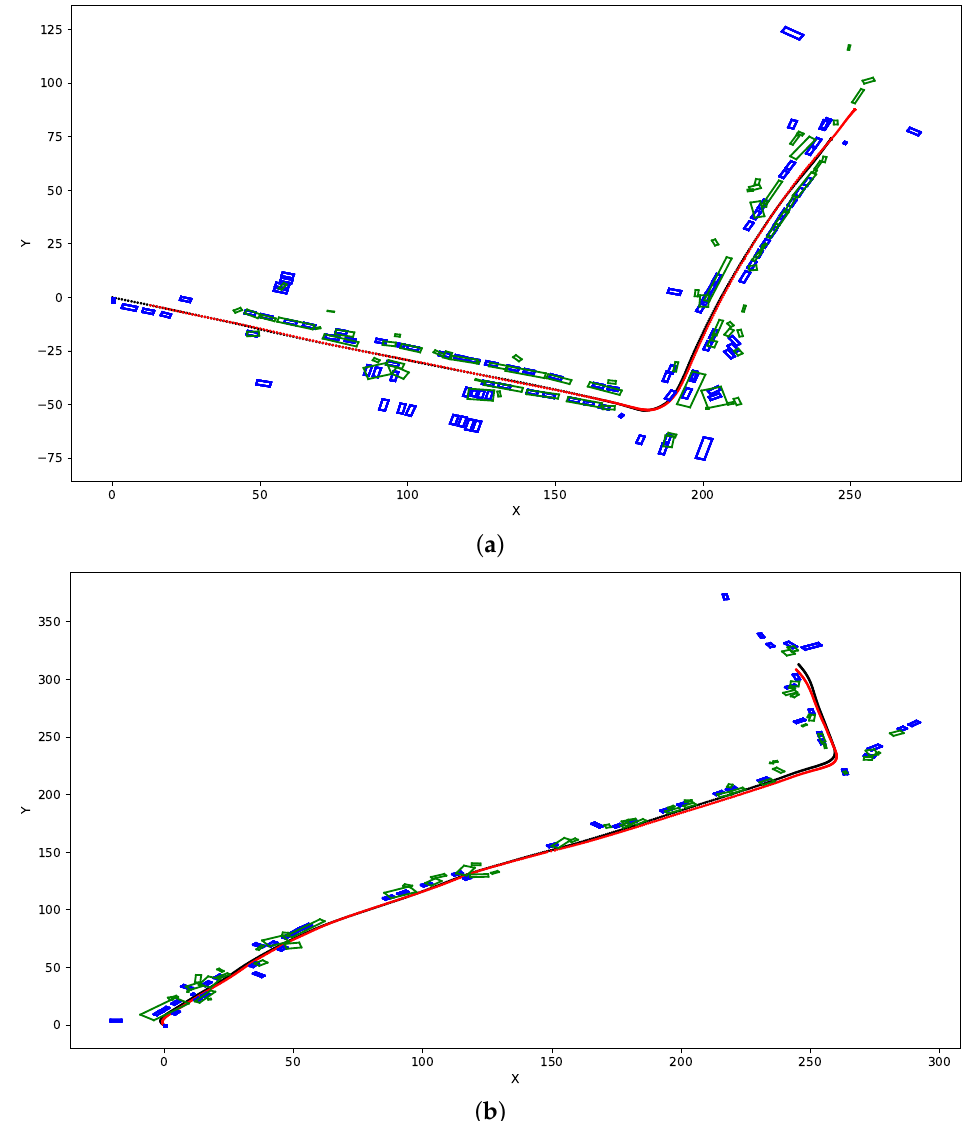
Figure 5. This figure presents example results of SLAM-OR algorithm with DBSCAN parameters: eps = 1 and min samples = 5. Black path and blue rectangles are reference data. Red line and green rectangles are results of the SLAM-OR. ( a ) SLAM and Bird’s Eye View mapping of Kitti 09 dataset. ( b ) SLAM and Bird’s Eye View mapping of Kitti 64